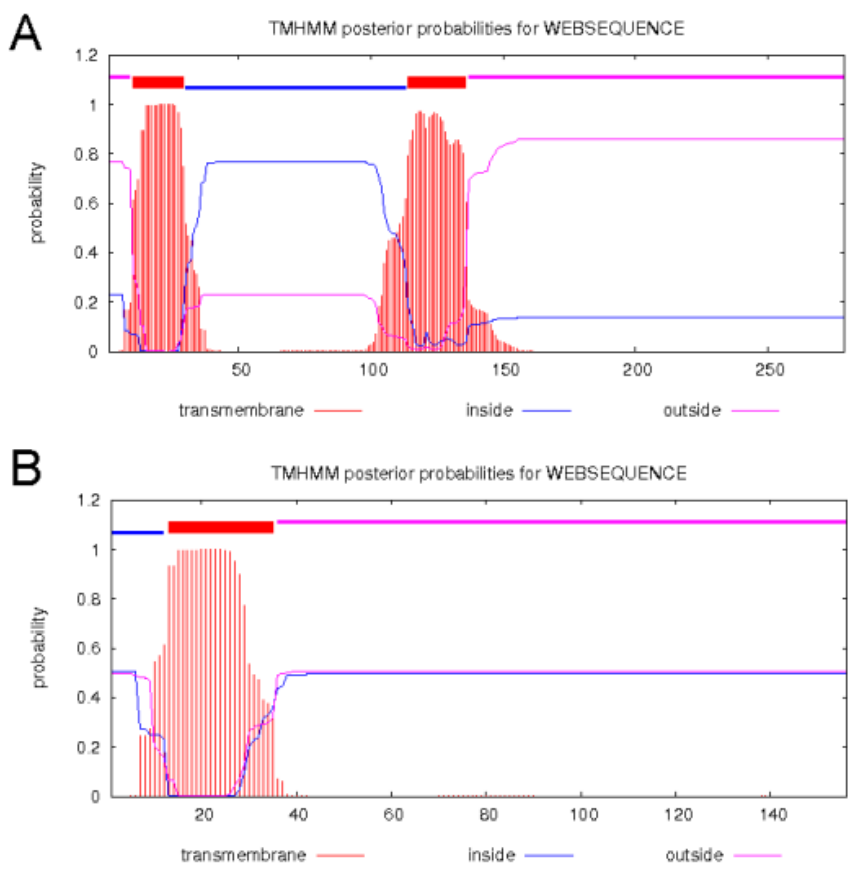
Figure 7. Transmembrane domain prediction of orf279 ( A ) and atp8 ( B